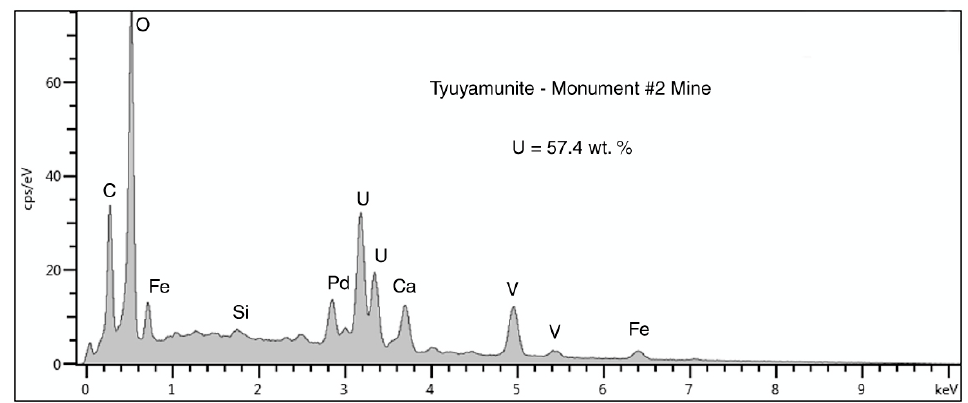
Figure 20. SEM / EDS spectrum of a surface crust of tyuyamunite on fossil wood from the Monument #2 Mine. The large carbon peak may be caused by small amounts of calcium carbonate. The Pd peak is a artifact from specimen coating to provide electrical conductivity. The small peak at 0 KeV is caused by detector noise. Table 2. SEM / EDS results for uranium mineral from Monument Mine #2. Element